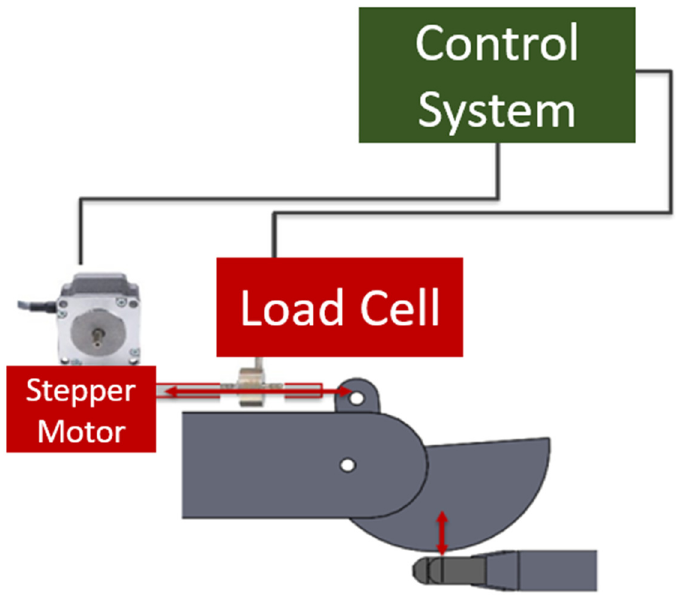
Figure 11. Diagram of the connections between the drum, motor, and control system.